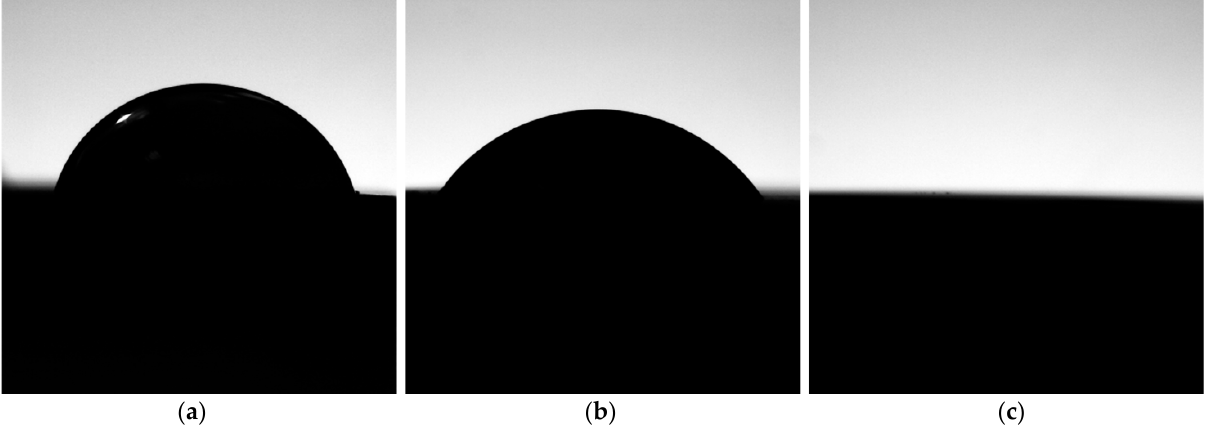
Figure 5. Wettability of different disc samples: ABT ( a ), Nano H 2 O ( b ) and Nano ( c ). The contact angles are respectively: 76.5; 55.3 and 0 (or not measurable).